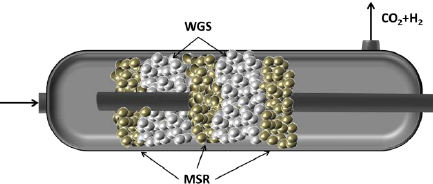
Figure 5. Conceptual illustration of the catalyst distribution throughout the PBR reactor with the left side cut away to show the tube and the catalyst.